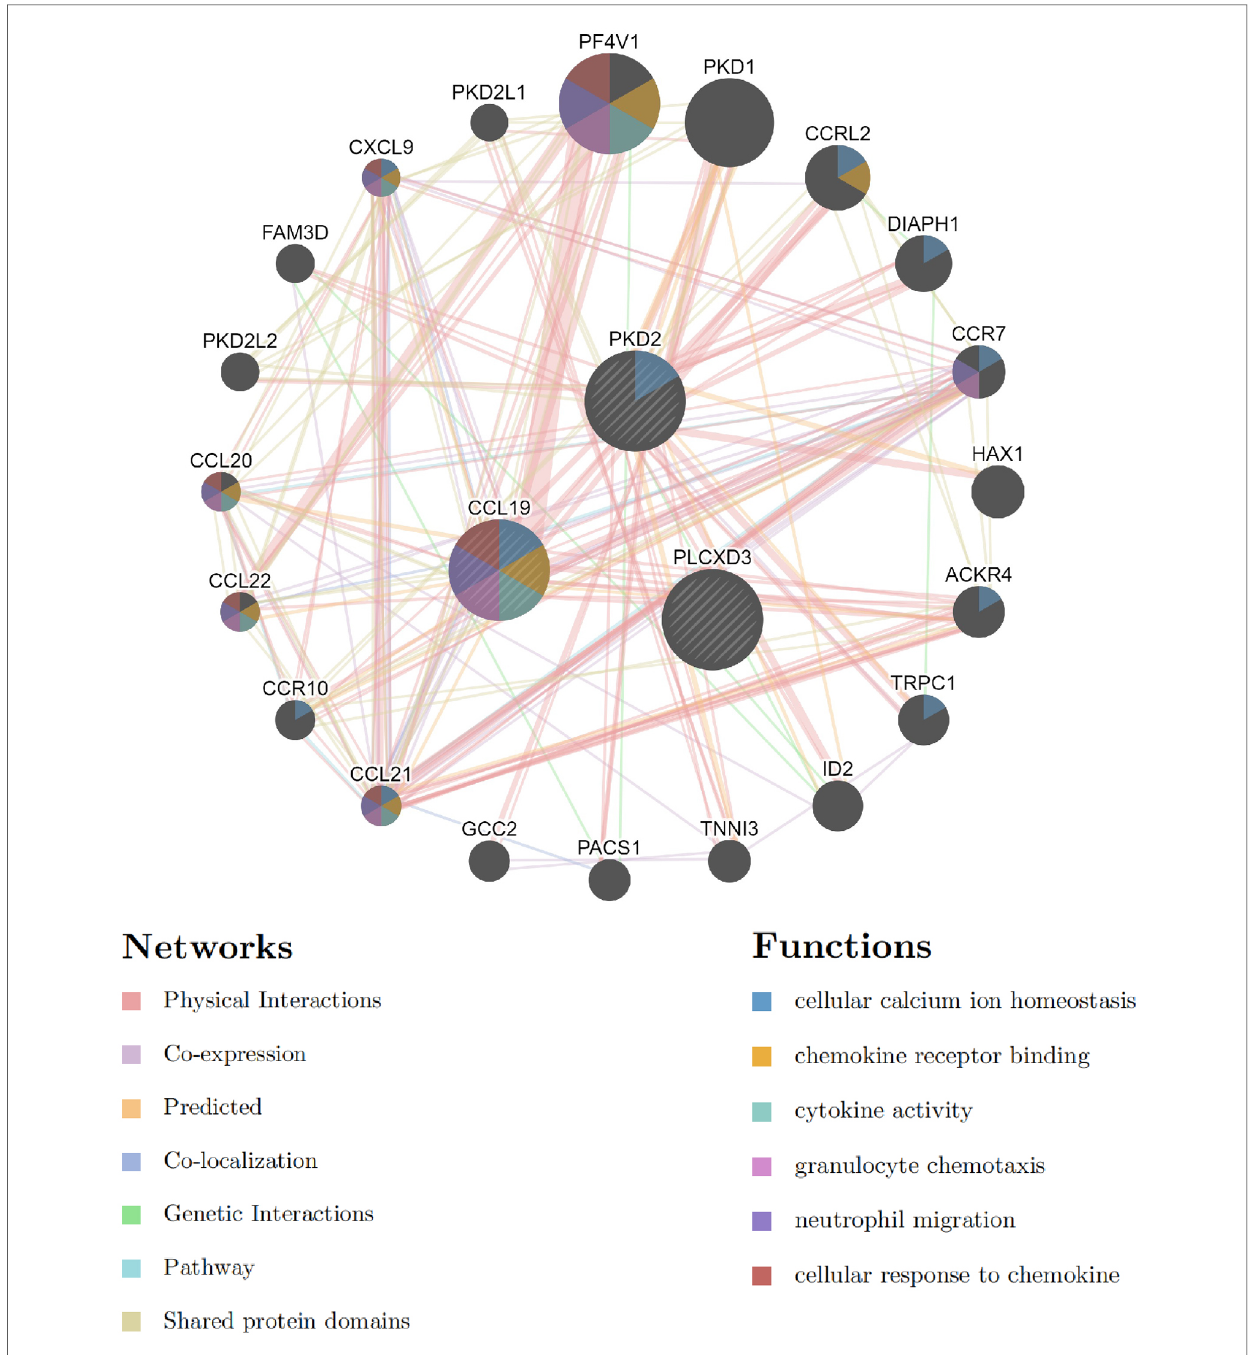
FIGURE 9 The common signature genes and their co-expression genes were analyzed via